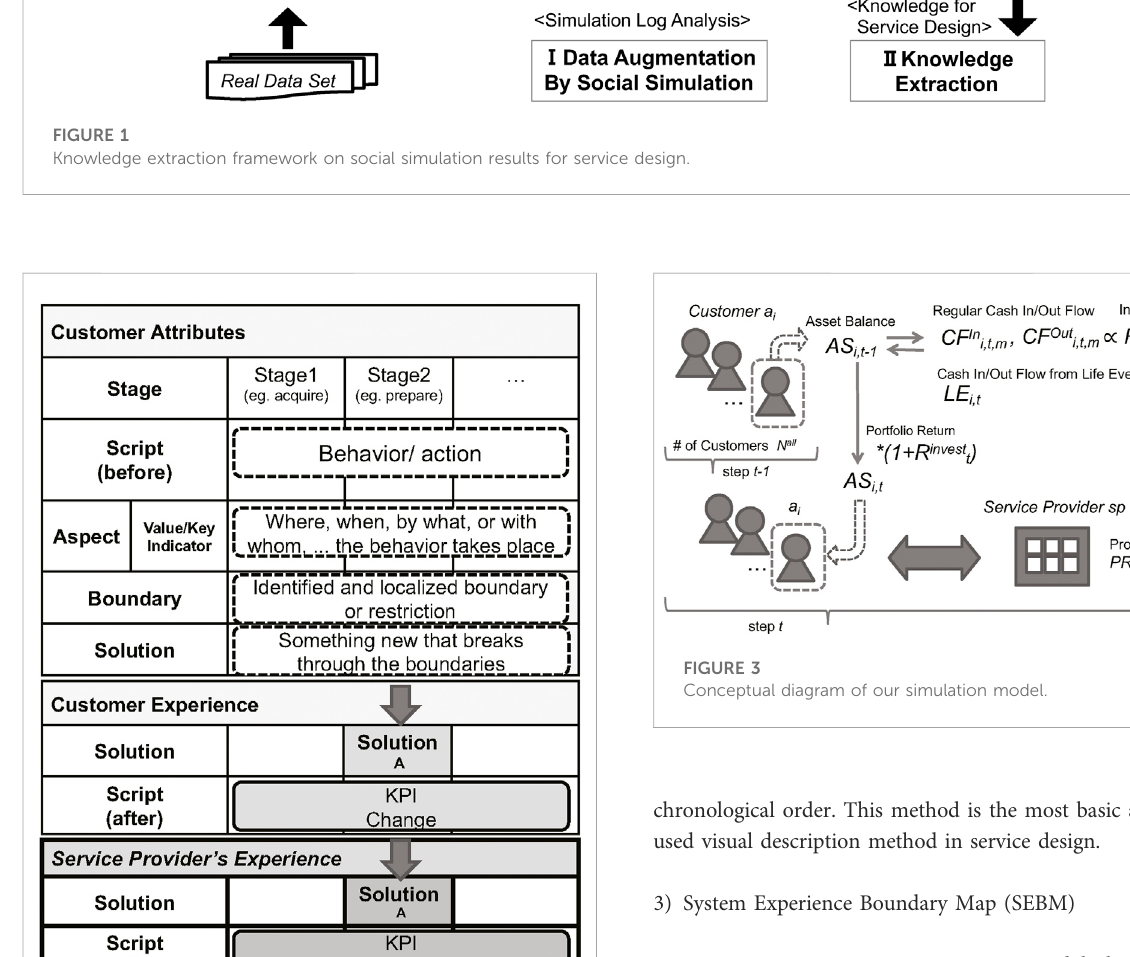
FIGURE 2 Conceptual diagram of extended SEBM.